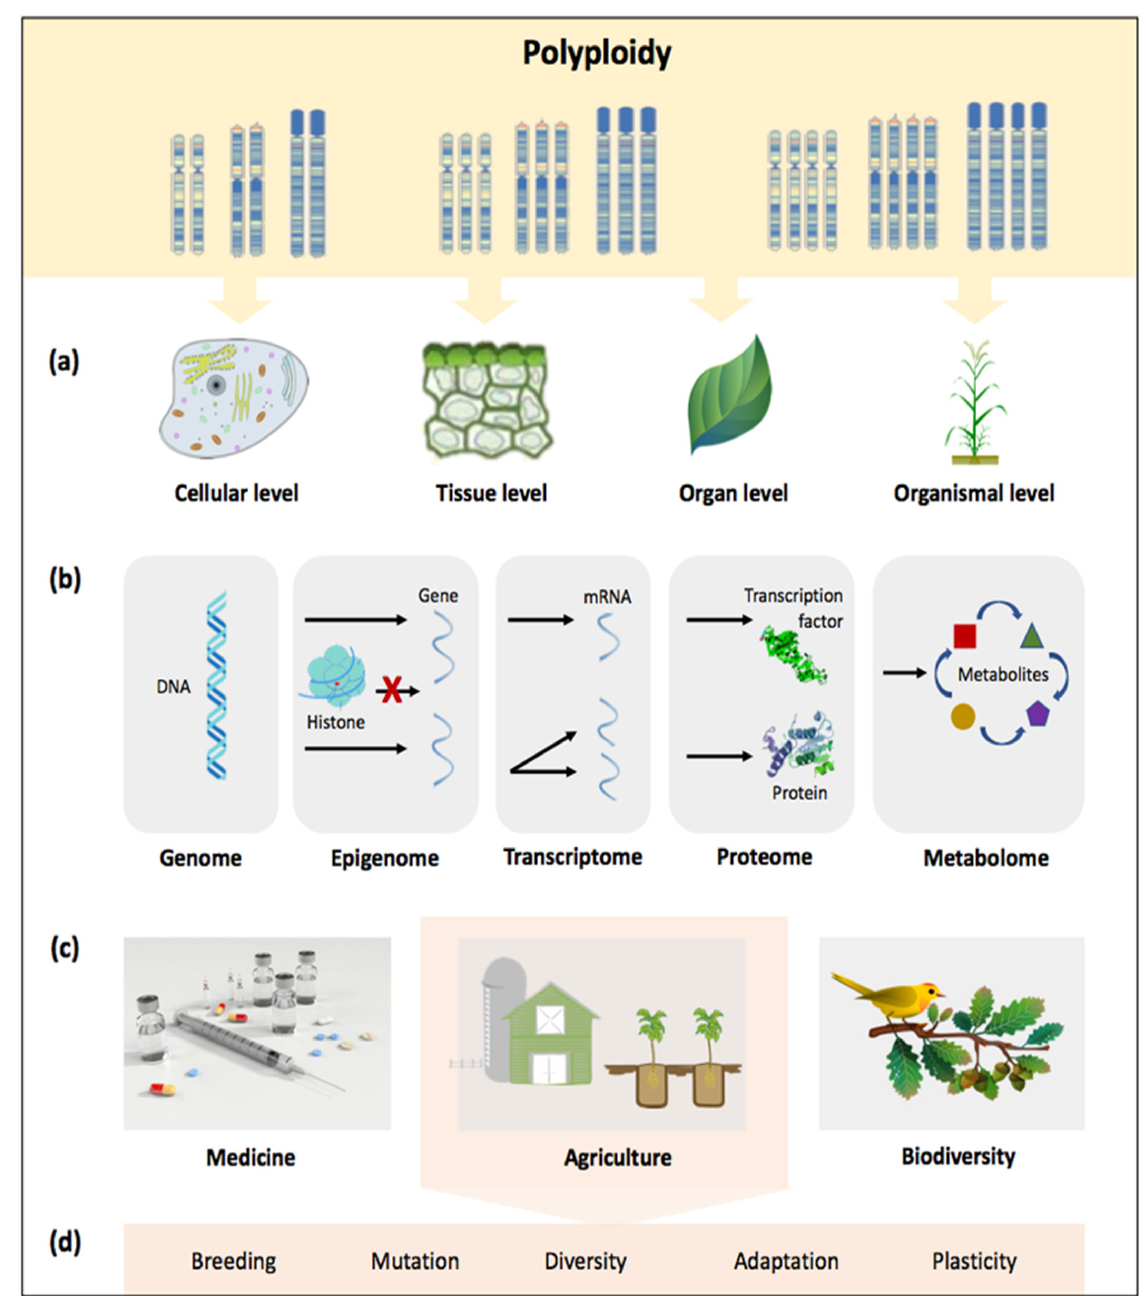
Figure 1. Advances in understanding polyploidy, with its role and implications from cells to ecosystems; ( a ) polyploidy involves the fusion of two or more genomes within one nucleus, affecting cells, tissues, organs, and organisms; ( b ) polyploidy as the product of a dynamic process in which restructuring of the genome, epigenome, transcriptome, proteome, and metabolome occurs through various changes; polyploidy as a biological force in ( c ) various fields and more specifically, ( d ) ag- riculture.